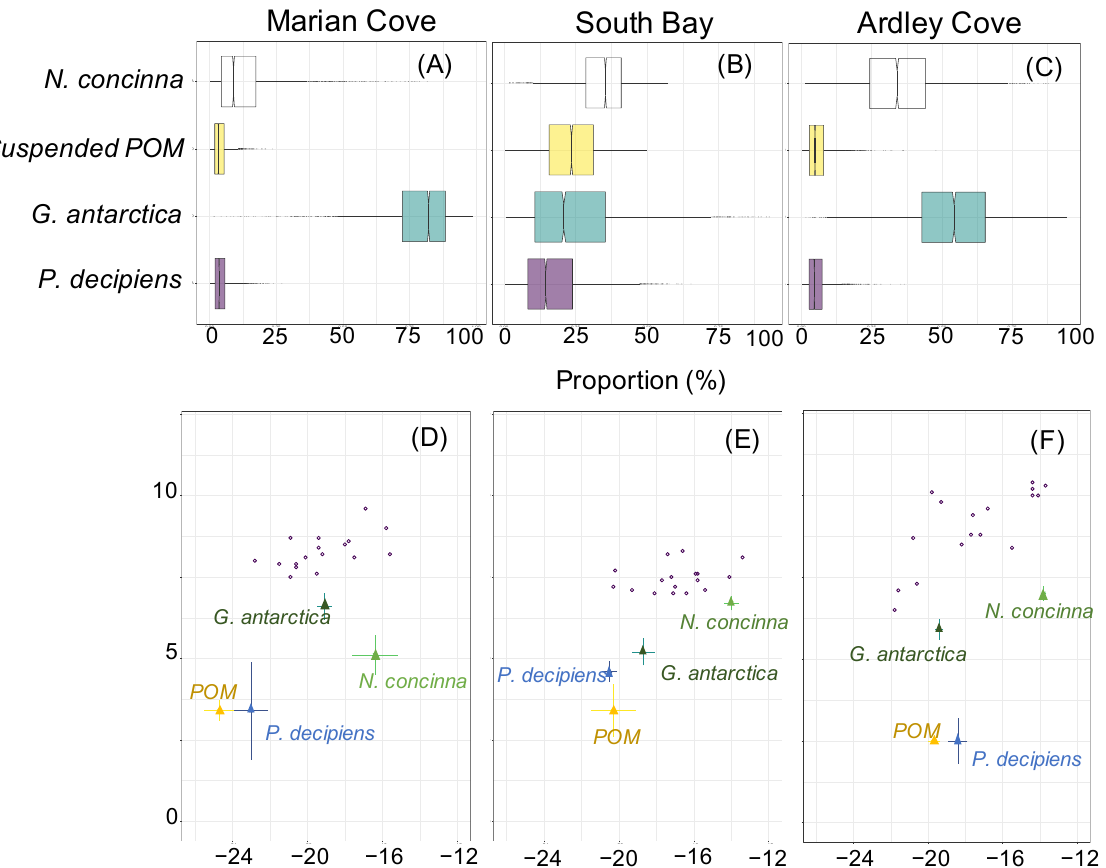
Figure 7. The top panel ( A – C ) presents the dietary composition of O. validus across regions according to simmr model. Boxplots represent 95% credible interval of primary food sources assimilation for each consumer. The centerline in the box is the median of all solutions, and the box is drawn around the 25% and 75% quartiles, thereby representing 50% of the solutions. The δ 13 C and δ 15 N values of consumers were corrected for the discrimination factor so that they could be compared to the prey values. In the bottom panel, bivariate stable isotope ratios of O. validus and their potential prey items from Marian Cove ( D ), South Bay ( E ), and Ardley Cove ( F ) are shown without the correction of the discrimination